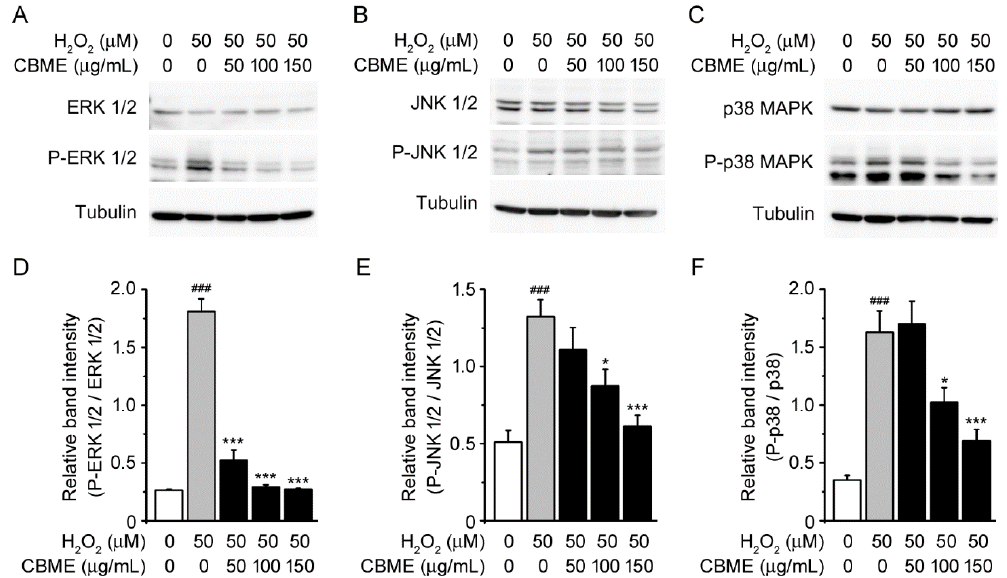
Figure 4. Effects of Chrysanthemum boreale Makino extract (CBME) on the MAPK pathway in SH-SY5Y cells exposed to H 2 O 2 . ( A ) Western blot bands corresponding to ERK 1/2 and P-ERK 1/2 in SH-SY5Y cells, which were pre-treated with the indicated concentrations of CBME for 3 h and then exposed to H 2 O 2 for 24 h. Tubulin was used as the loading control. ( B ) Western blot bands corresponding to JNK 1/2 and P-JNK 1 / 2 . ( C ) Western blot bands corresponding to p38 and P-p38. ( D ) Relative band intensity of P-ERK 1/2 was quantified using densitometric analysis and then normalized to that of ERK 1/2. ( E ) Relative band intensity of P-JNK 1/2 was quantified using densitometric analysis and then normalized to that of JNK 1/2. ( F ) Relative band intensity of P-p38 was quantified using densitometric analysis and then normalized to that of p38. Values in the bar graphs are the mean ± SEM of at least three independent experiments. *** p < 0.005, * p < 0.05, significantly different from the H 2 O 2 group. ### p < 0.005, significantly different from the control group.